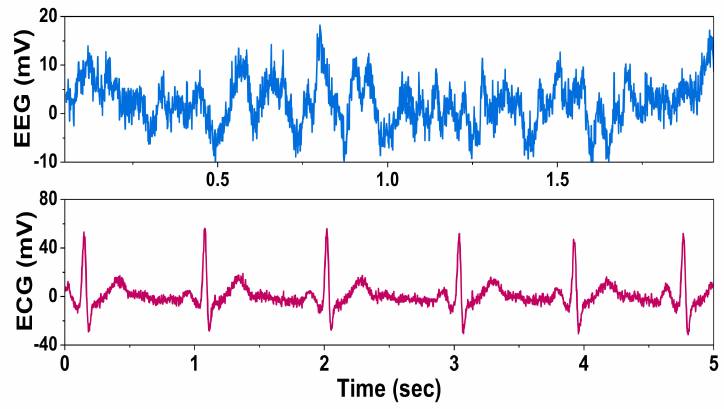
Figure 16. Measured output of the